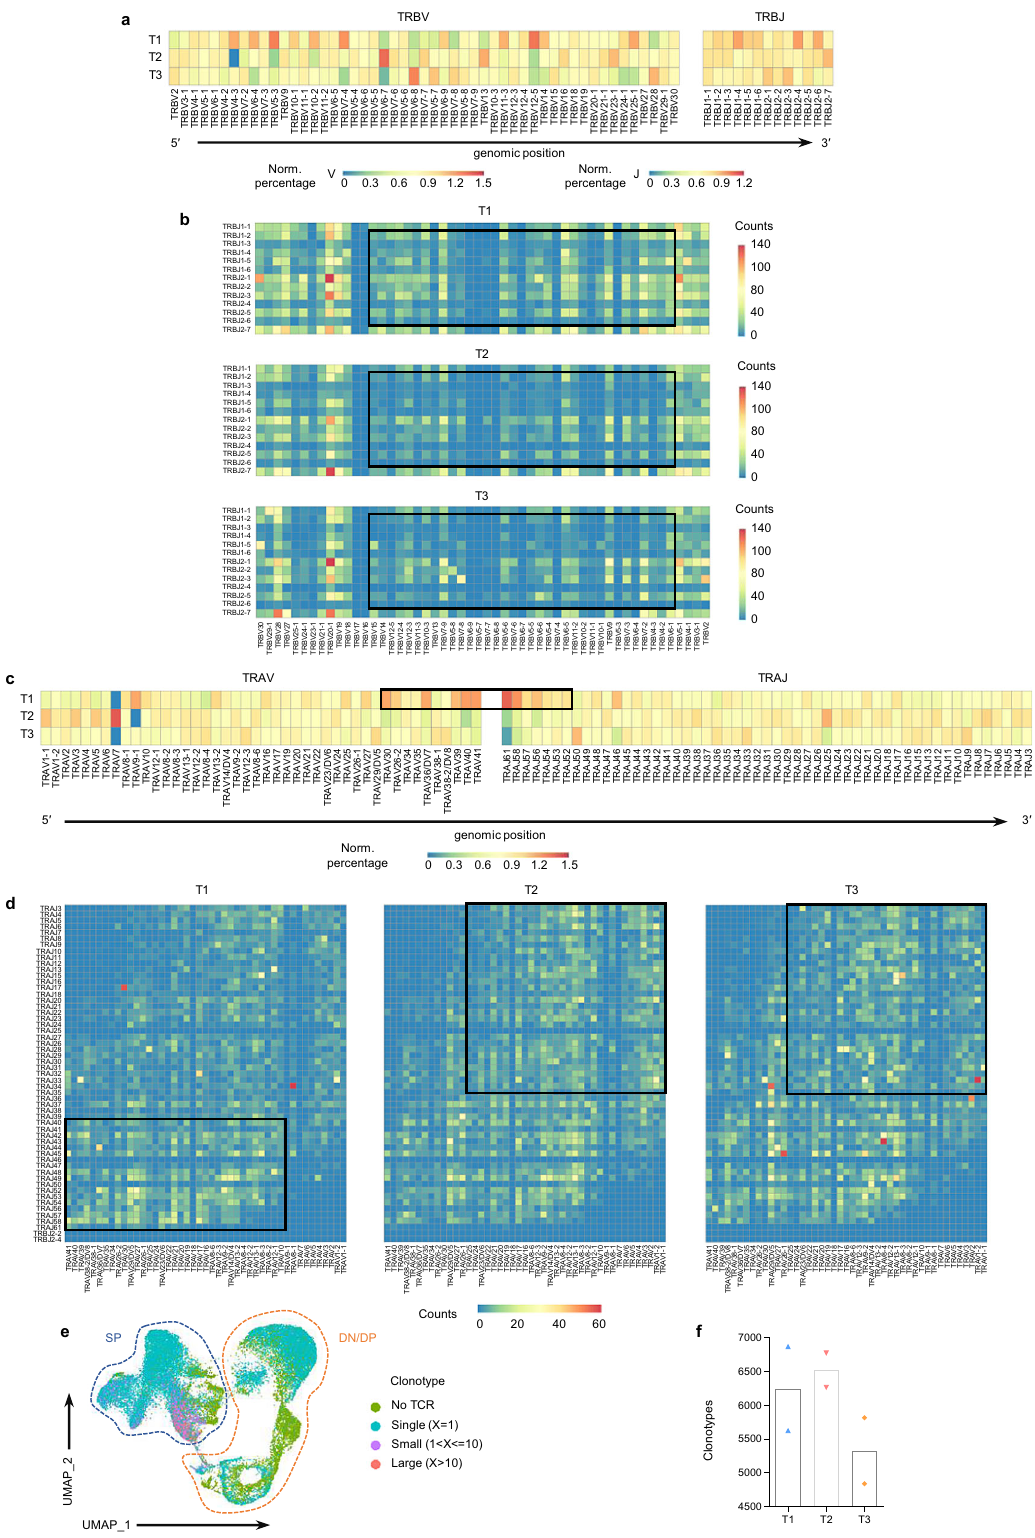
Fig. 4 | VJ gene usage and pairing and TCR diversity in TET subtypes. ( a ) Heatmap showing the proportion of each TCR β V and J gene segment present in total T cells from each group, normalized per column. Gene segments positioned accordingtogenomiclocation.( b )FrequencyofV-JgenepairsattheTCR β locusof each group. ( c ) Same scheme as in ( a ) applied to TCR α V and J gene segments,